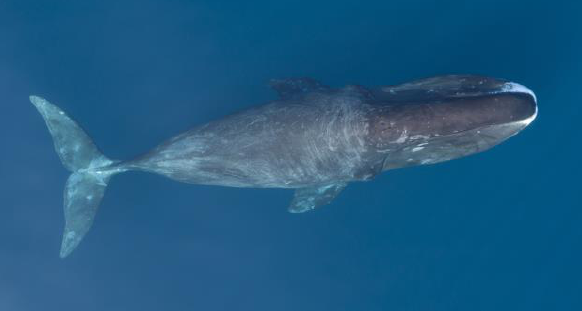
Figure 1. Bowhead whale, Cumberland Sound 2019. Photo credit: Ricky